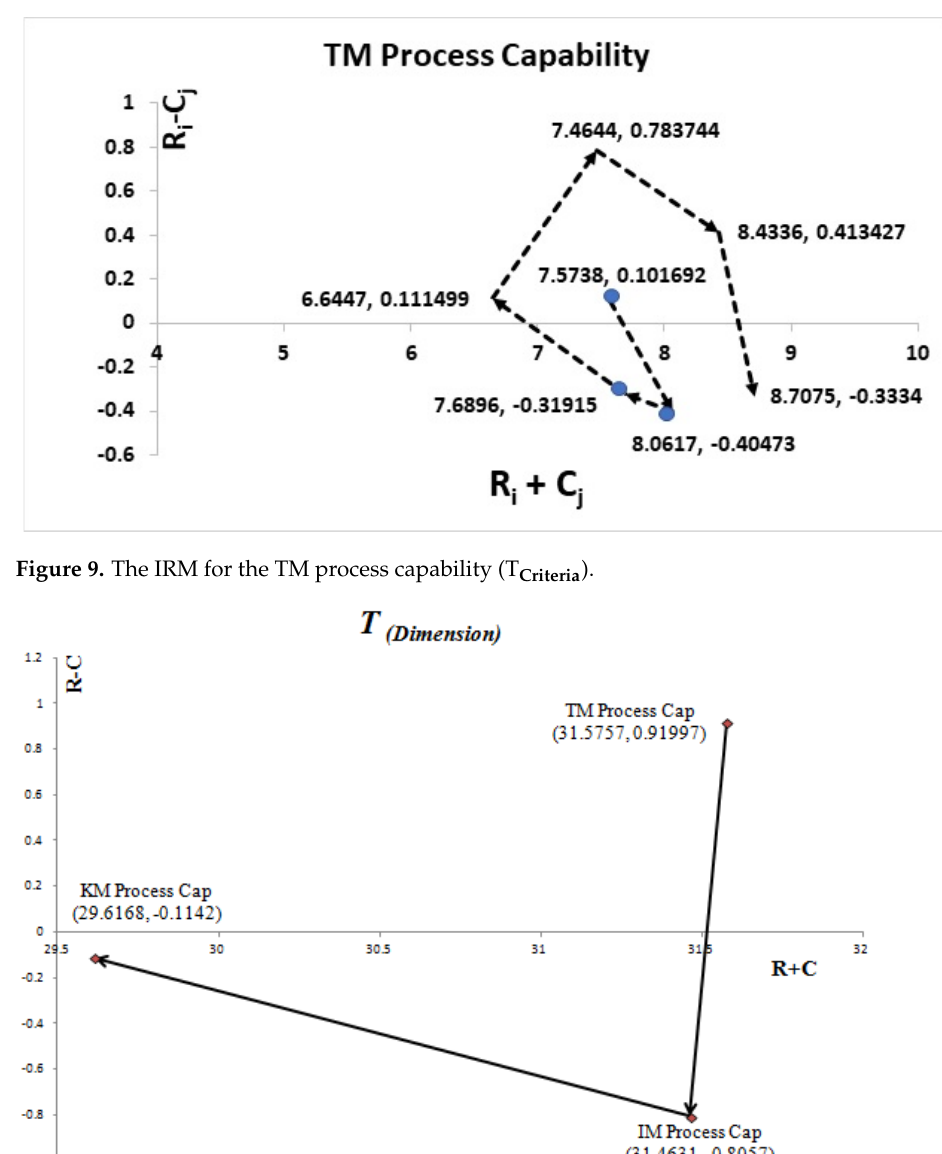
Figure 8. The IRM for the IM process capability (T Criteria ).